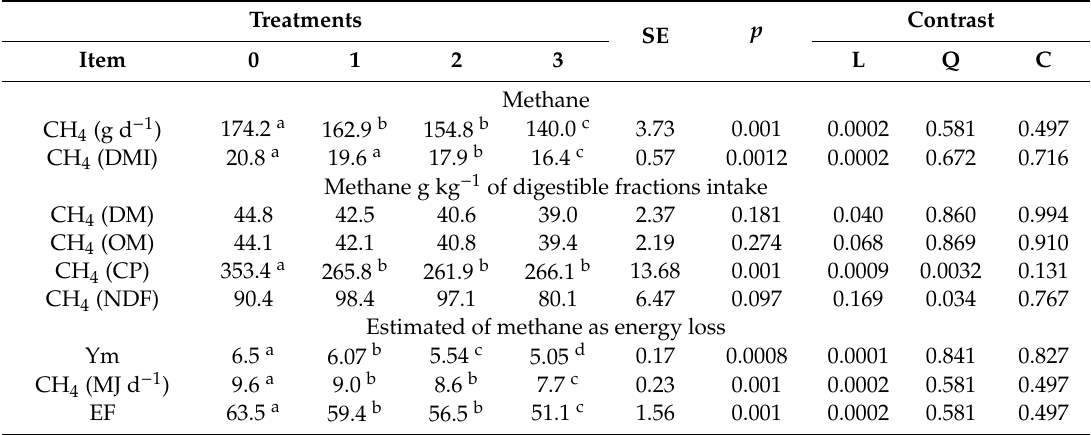
Table 8. E ff ect of supplements of dried L. leucocephala leaves on enteric CH 4 production in heifers. Contrast Treatments SE p Item 0 1 2 3 L Q C Methane